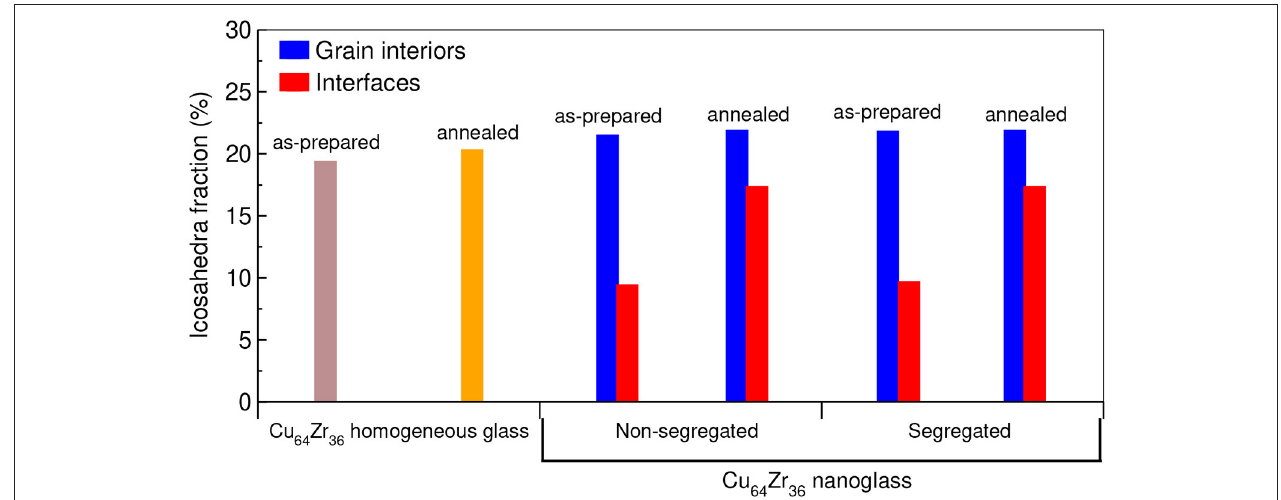
FIGURE 2 | Fraction of Cu-centered full icosahedra in the grain interiors and interfaces of the as-prepared and annealed Cu 64 Zr 36 non-segregated and segregated nanoglasses. As-prepared and annealed homogeneous glasses with identical chemical composition are shown for comparison. Annealing is performed at a temperature of 600K ( ≈ 0.8T g ) for 500ns.